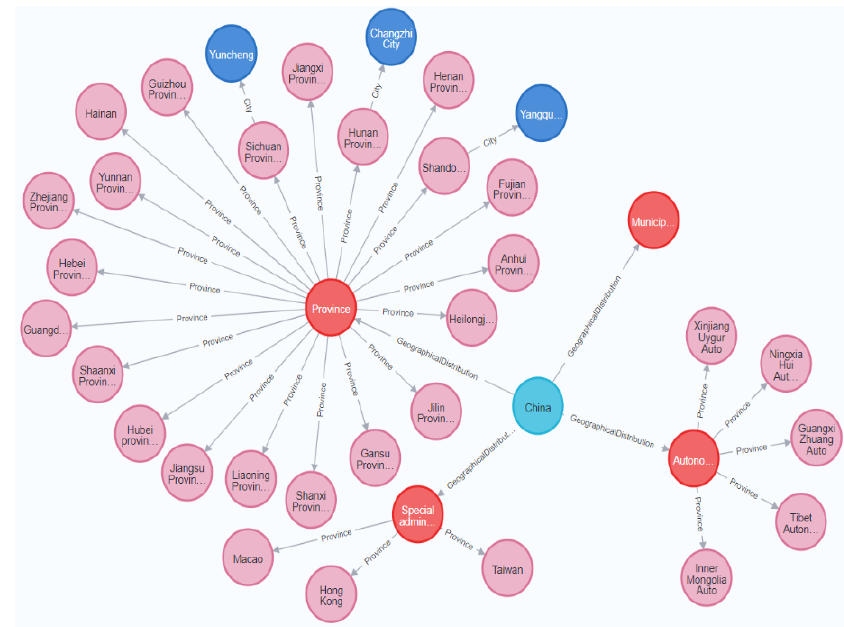
Figure 2. Part of Chinese tourism Knowledge Graph.